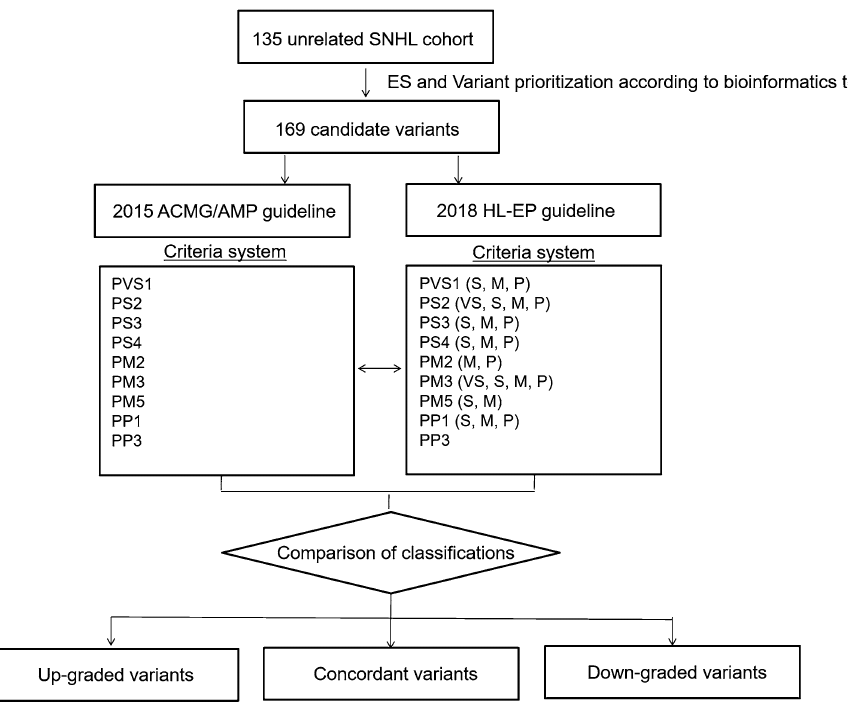
Figure 1. The study design of the present study. The 169 variants of 135 genetically unrelated sensorineural hearing loss probands were classified based on the 2015 ACMG/AMP and 2018 HL-EP guidelines. The variants classification between the 2015 ACMG/AMP and 2018 HL-EP guidelines were compared.